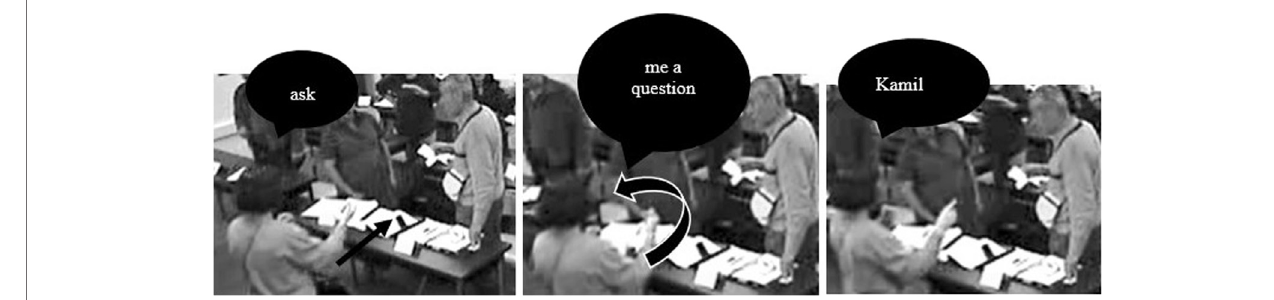
FIGURE 1 | Extract 1, line 1.